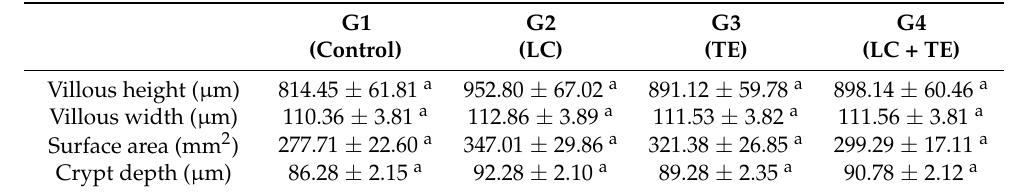
Table 5. Effect L-Carnitine and/or calf thymus extract supplementation on duodenal histomorpho- logical parameters in Japanese quail (mean ± SE), n =